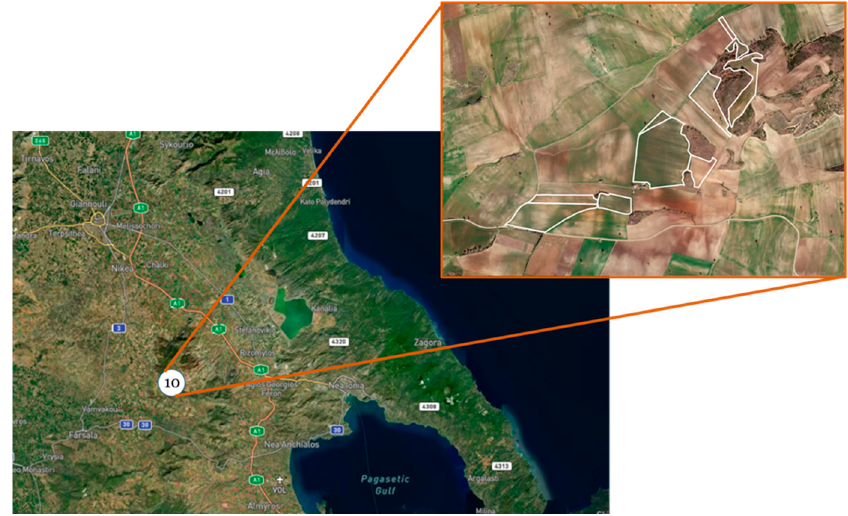
Figure 3. Overview of the study area within Larisa region, the sampling site (orange rectangle), and parcels (white polygons).